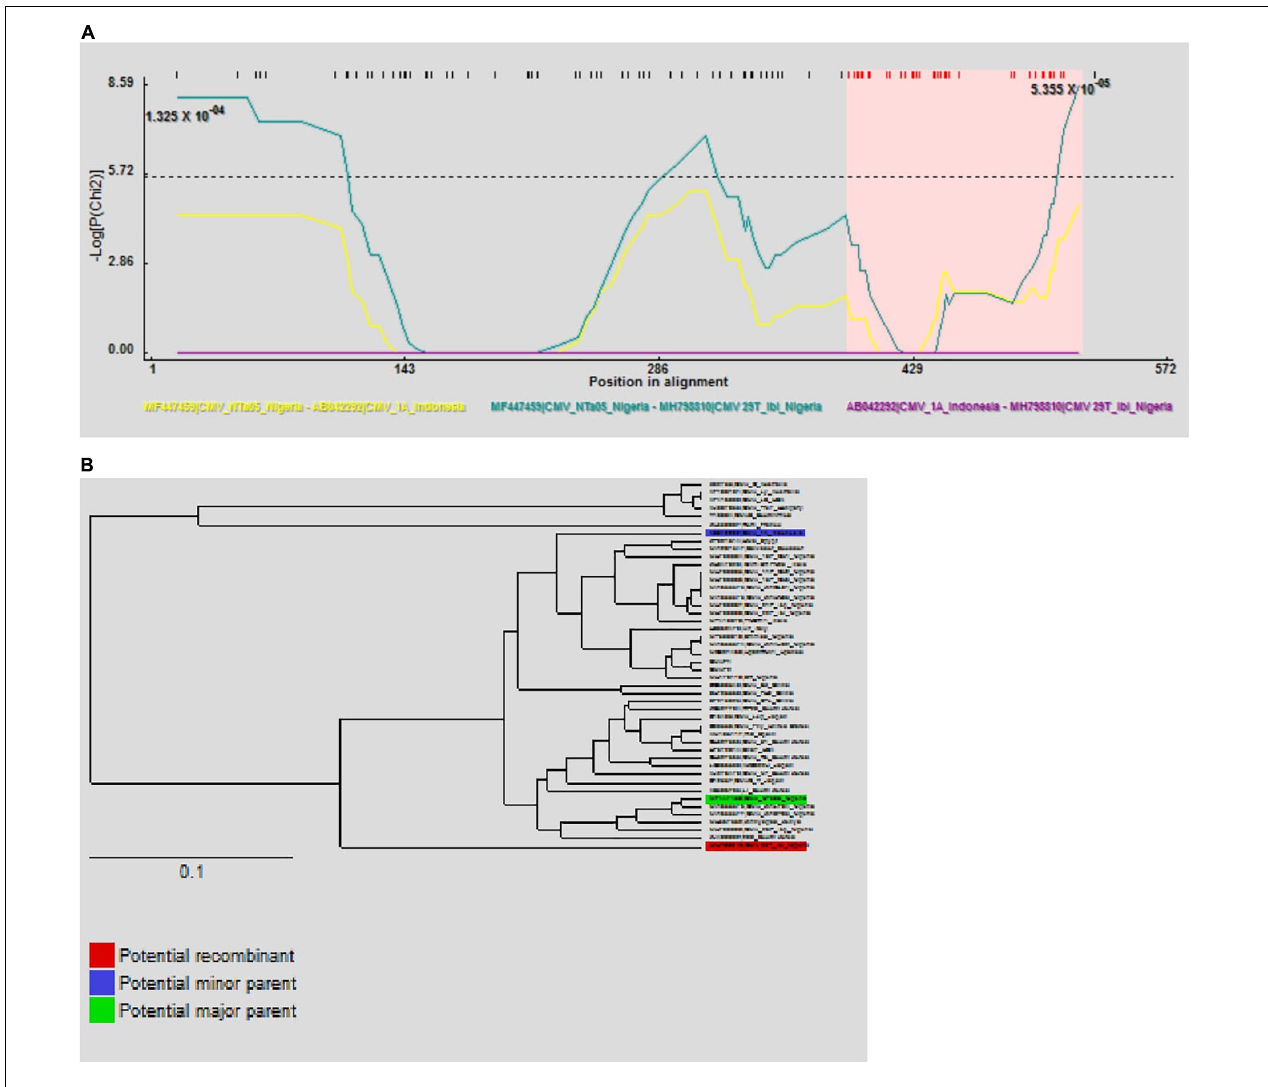
FIGURE 5 | Putative recombination events on partial RNA1 sequences of CMV isolate ‘29T_Ibi’ on the RPD program. The –Log P maxChi values between the possible recombinant and its putative parents are shown and the pink colored region represents the potential region of recombination (A) . Phylogenetic inferences show putative parents in different clusters (B)